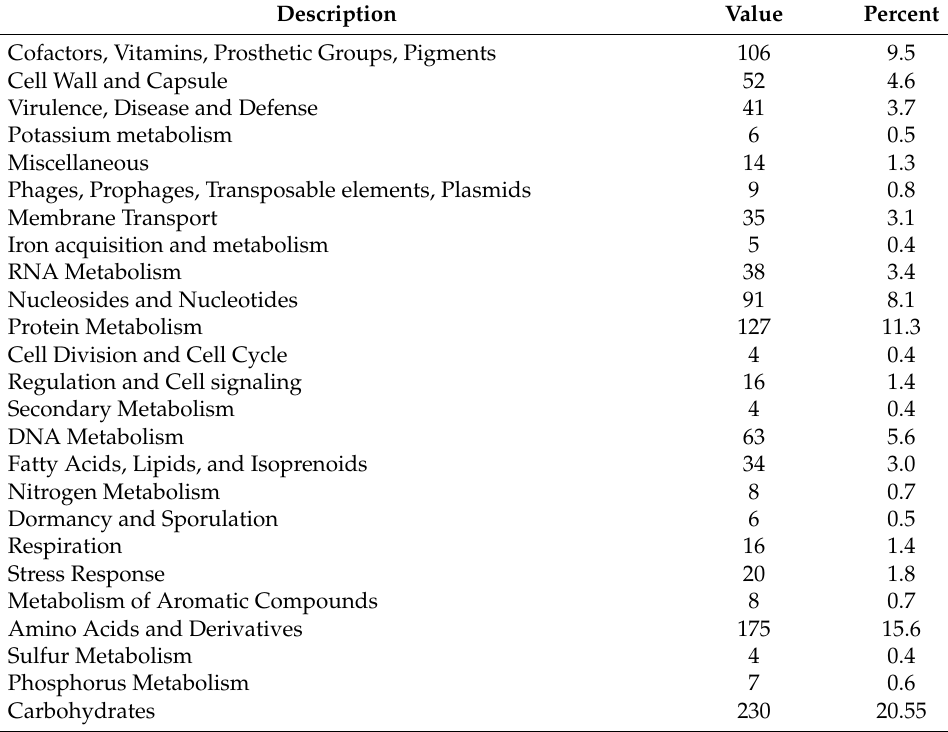
Table 2. General overview of biological subsystem distribution of the genes by RAST